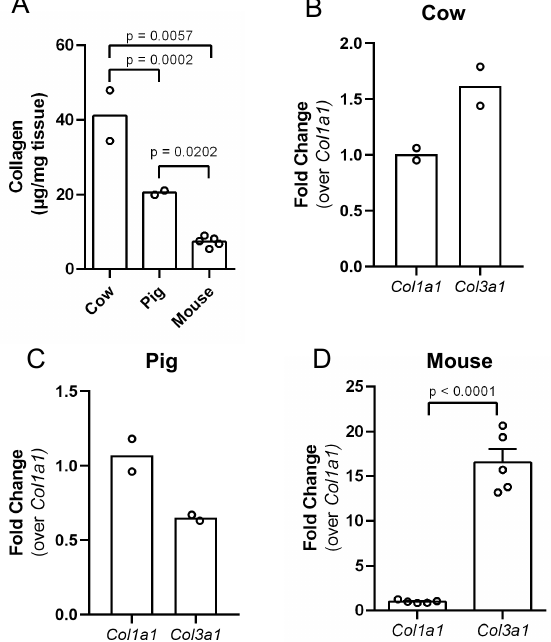
Figure 3. Collagen protein and type I collagen transcripts in bovine ovarian stromal tissue and whole porcine and mouse ovaries. ( A ) Collagen content in bovine ovarian stromal tissue, porcine ovaries, and mouse ovaries determined by the hydroxyproline assay. Relative gene expression of the collagen genes Col1a1 and Col3a1 in ( B ) bovine ovarian stromal tissue, ( C ) porcine ovaries, ( D ) mouse ovaries. The data are shown as a fold change in transcript content over Col1a1 . n = 2 cow ovaries, n = 2 pig ovaries, n = 5 mouse ovaries. Circles represent values from individual animals. Statistical analysis was performed using the Student’s t-test. p -values are as